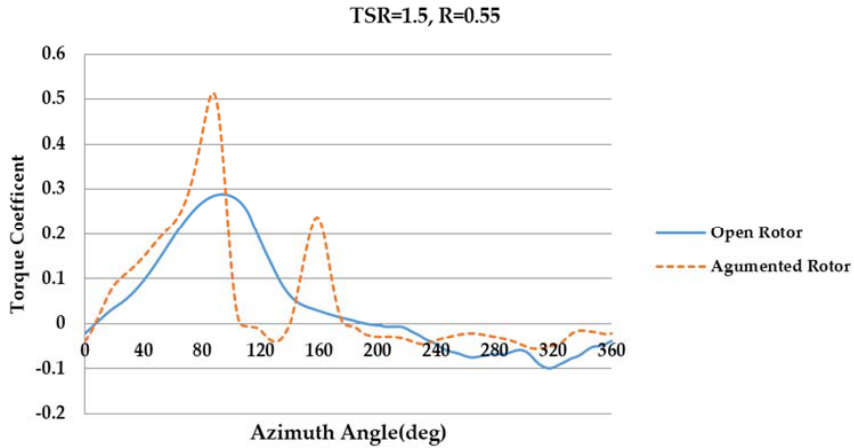
Figure 22. Torque coefficient versus azimuth angle for open and augmented rotor for TSR = 1.5, R shape ‐ ratio = 0.55.